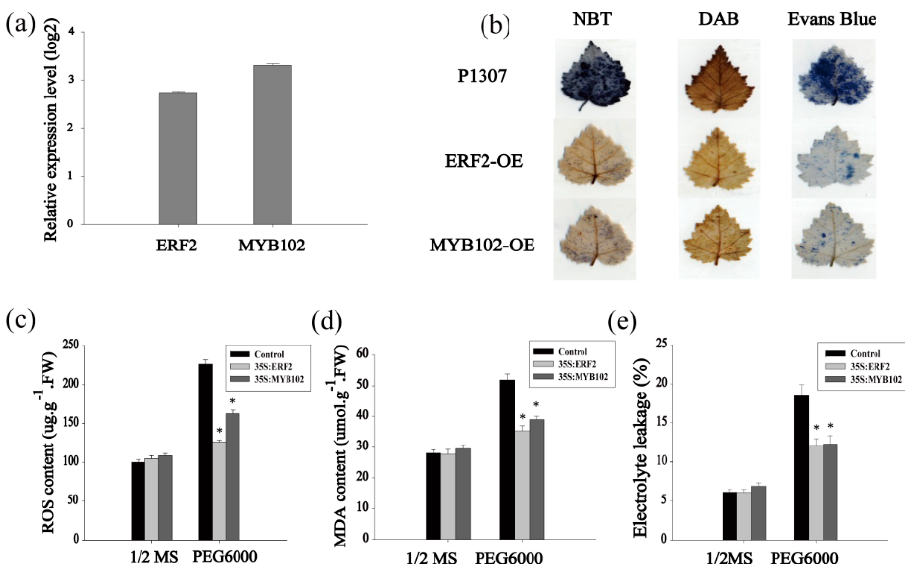
Figure 3. Analysis of drought stress tolerance of BpERF2 and BpMYB102 in birch. Three kinds of transgenic plants were compared: plants transiently transformed with 35S:BpERF2, 35S:BpMYB102, and empty p1307-Flag (as the control). ( a ) The study of the expression of BpERF2 and BpMYB102 in transiently transformed plants using qRT-PCR. ( b ) NBT, DAB, and Evans blue staining of leaves from the three kinds of plants. ( c – e ) Comparison of ROS content ( c ), MDA content ( d ), and electrolyte leakage ( e ) among the three kinds of plants under normal or drought stress conditions. 1 / 2 MS: the plants grown on 1 / 2 MS medium as the control; PEG6000: the plants grown on 1 / 2 MS medium supplying with 20% PEG6000, which is used as drought stress. Asterisks indicates a significant di ff erence between treatment and control plants ( p <